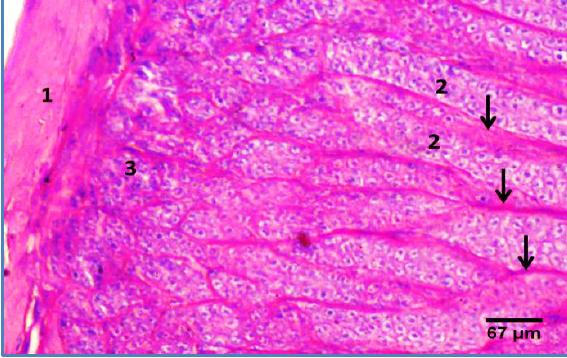
Figure, 10: Flamingo's salt gland shows: Collagenous capsule (1), branched tubuloacinar lobules (2), acini (3) and septa (Arrows), combined (AB-PAS) stain .